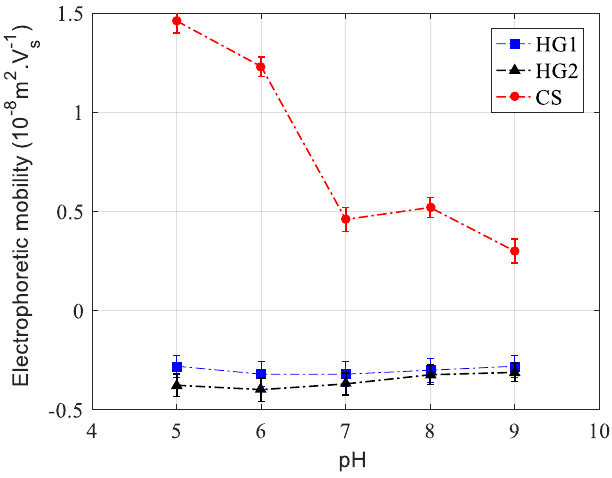
Figure 3. Electrophoretic mobility of CS, HG1, and HG2 as a function of pH at 25 °C and in 10 mM phosphate buffer.